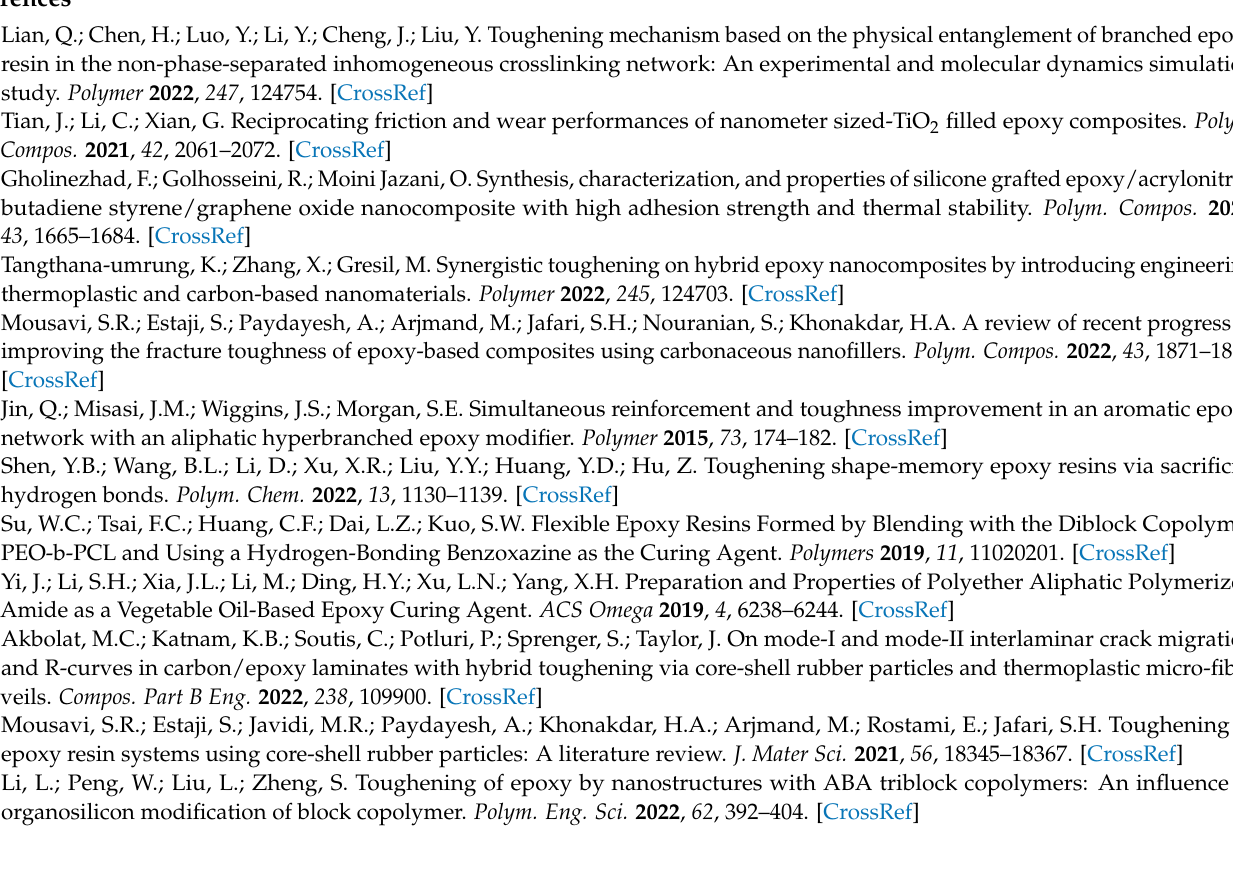
exothermic peak temperature and heating rate: A E51, B 10 phr-PPENK/E51. Figure S2: Fitting line of E51/DDS: A Kissinger method, B Ozawa method; Figure S3: Fitting line of 10%-PPENK/ E51/DDS: A Kissinger method, B Ozawa method; Figure S4: A DSC curves and B TGA curves of PPENK. Figure S5: A Typical tensile load–displacement curves, B Typical flexural load–displacement curves; Figure S6: Curing molds for PPENK/E51 blends; Table S1: Curing exothermic peak temperature of E51 at different heating rates. Table S2: Curing exothermic peak temperature of PPENK/E51 at different heating rates. Table S3: The crosslinking density of different blend systems. Table S4 DSC data and TGA data of PPENK; Table S5: The mechanical properties of blends at room temperature and ultra-low